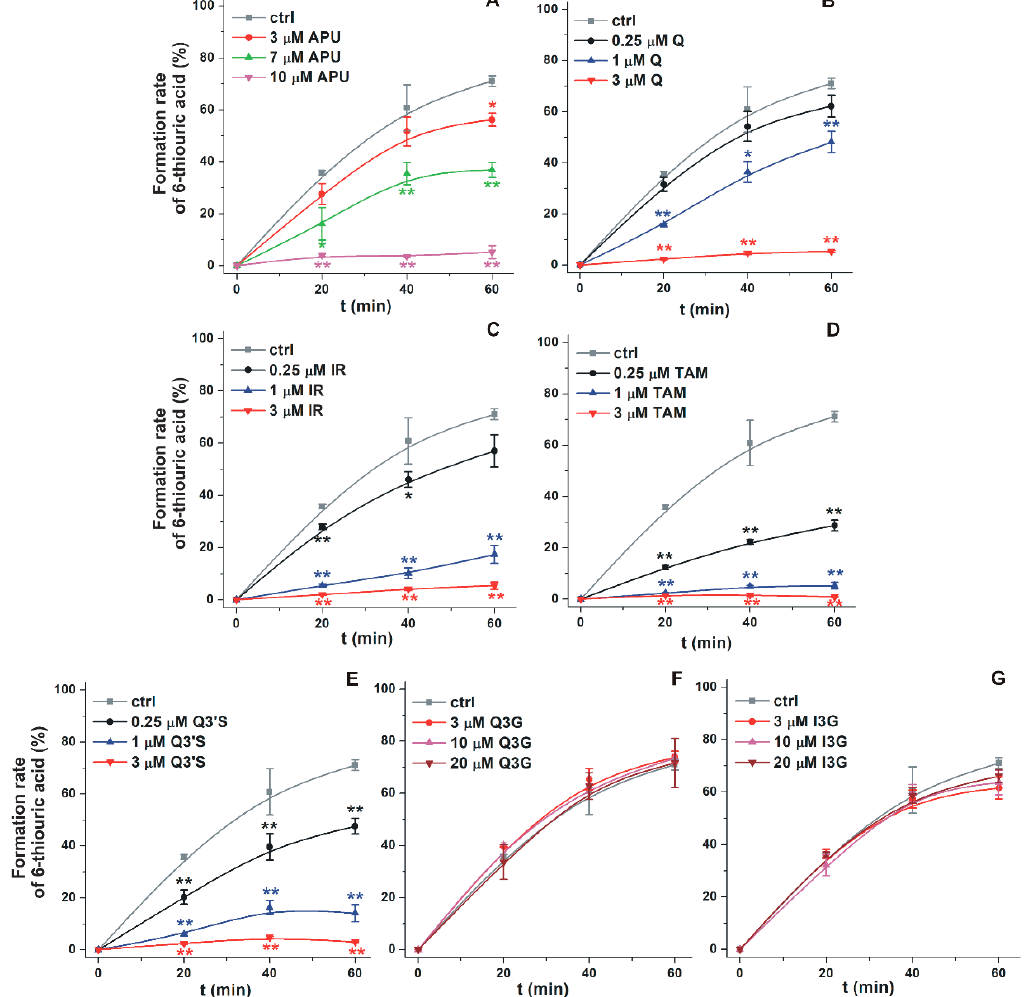
Figure 2. The time course of XO-catalyzed formation of 6-thiouric acid in the presence of increasing concentrations of APU, Q, and conjugated Q metabolites (see further details in the Materials and Methods). Graphs depict % conversion of 6-MP to 6-TU in the absence and presence of increasing concentrations of allopurinol (APU; A ), quercetin (Q; B ), isorhamnetin (IR; C ), tamarixetin (TAM; D ), quercetin-3 ′ -sulfate (Q3 ′ S; E ), quercetin-3-glucuronide (Q3G; F ), and isorhamnetin-3-glucuronide (I3G; G ) (* p < 0.05; ** p < 0.01).